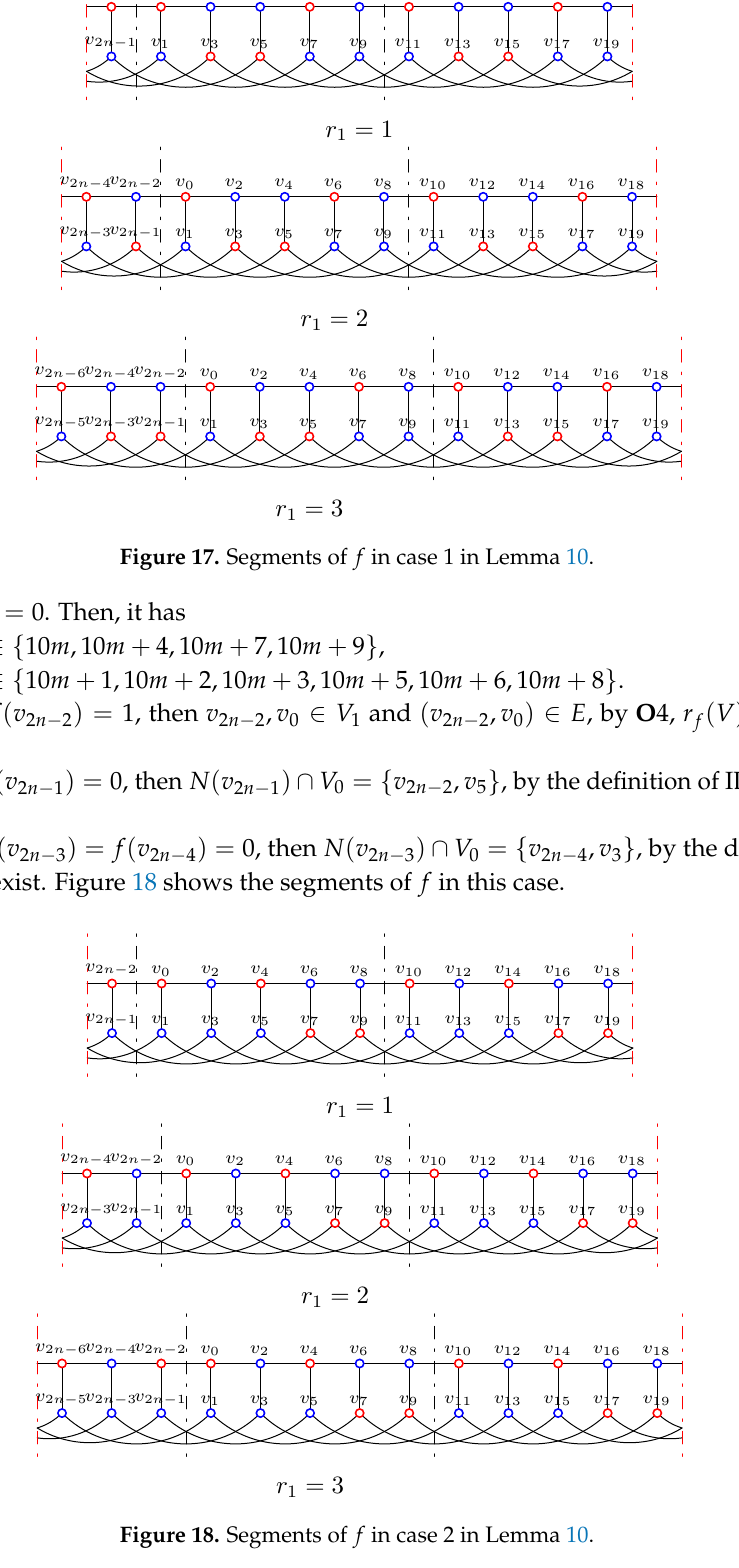
Figure 18. Segments of f in Case 2 in Lemma 10.